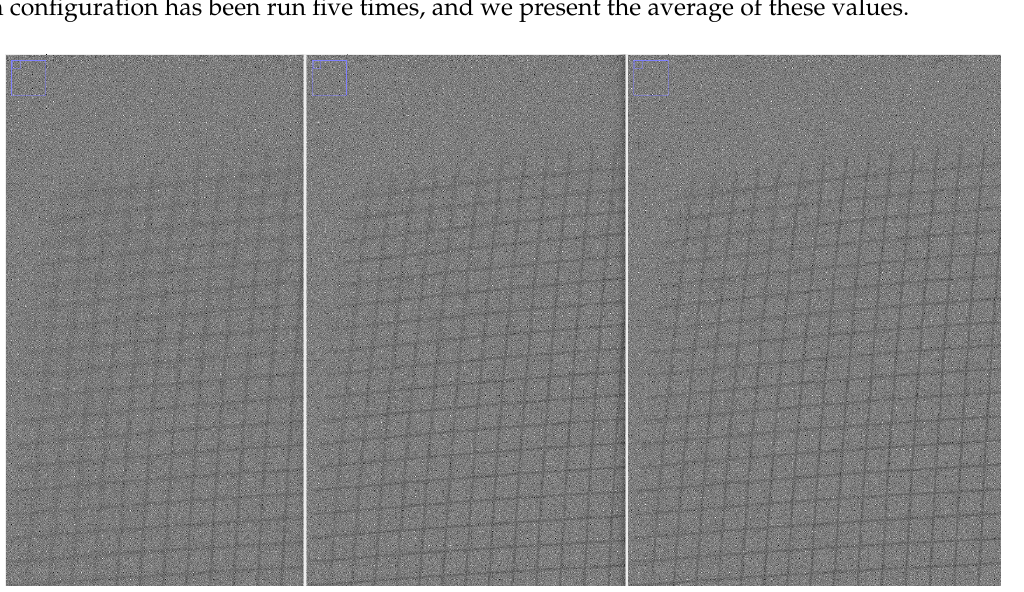
Figure 18. Normalized micrograph of the phantom movie produced by MotionCor2, using different number of patches: 5 × 5 ( left ), 7 × 7 ( middle ), 9 × 9 ( right ). Table 2. HW used for benchmarking.